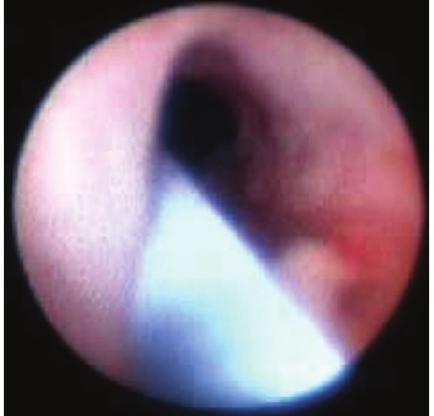
Figure 4: Endoscopic view of the angiographic catheter which served as a guide for the